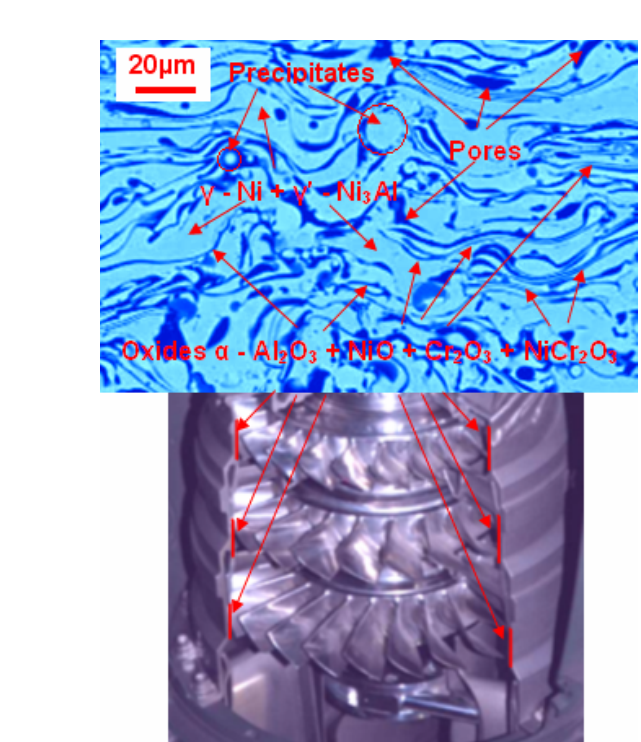
Figure 4 – Duct of the ASTAZOU III B turbojet engine and the microstructure of the Ni22Cr10Al1Y coating Рис . 4 – Промежуточный контур турбореактивного двигателя ASTAZOU III B и микроструктура покрытия Ni22Cr10Al1Y Slika 4 – Sprovodni aparat turbomlaznog motora ASTAZOU III B i mikrostruktura prevlake